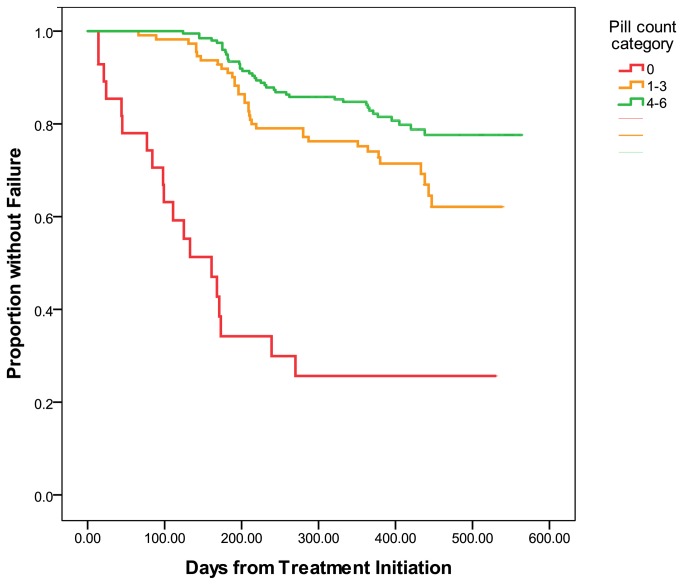
Time to Treatment Failure by Number of Pill Counts Performed.Time to treatment failure increased as the number of pill counts increased (none = 220 days, 1-3 = 438 days and = 497 days, P < 0.01).